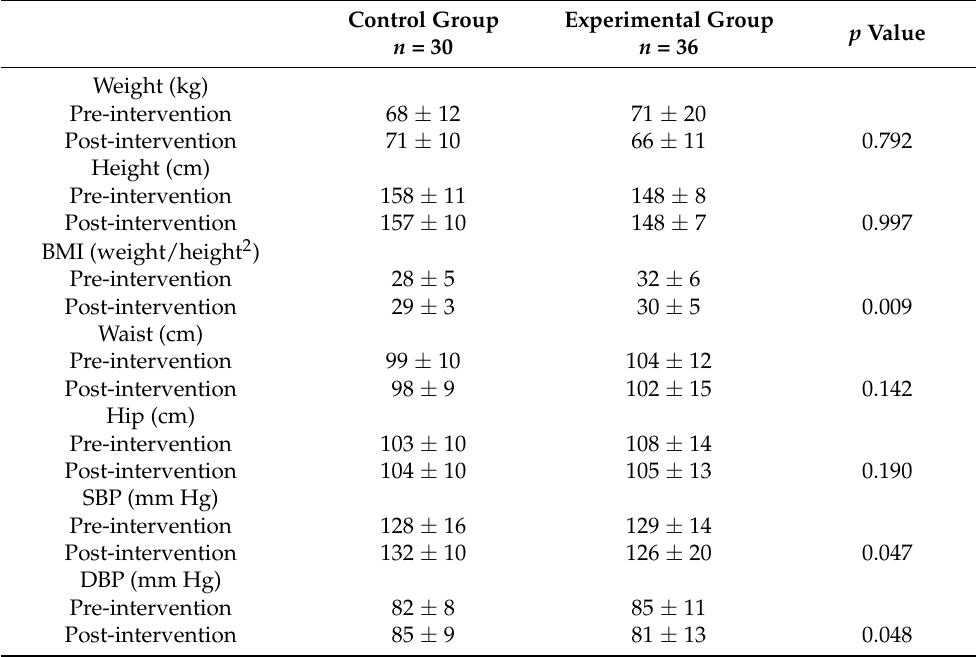
Figure 3. Percentage of the number of MS criteria pre and post-intervention. In ( A ) (control group) pre-intervention, 28/30 (94%) subjects had 3 MS criteria, 1/30 (3%) had 4 MS criteria, and 1/30 (3%) had 5 MS criteria; post-intervention, 5/30 subjects (17%) changed from 3 to 2 MS criteria, 28/30 (94%) changed to 9/30 (30%) with 3 MS criteria, 1/30 (3%) changed to 12/30 (40%) with 4 MS criteria and 1/30 (3%) changed to 4/30 (13%) with 5 MS criteria. In ( B ) (experimental group), pre-intervention 28/36 (78%) subjects had 3 MS criteria, 7/36 (19%) had 4 MS criteria, and 1/36 (3%) had 5 MS criteria; post-intervention, 2/36 subjects (6%) changed from 3 to 0 MS criteria, 12/36 (33%) changed from 3 to 1 MS criteria, 12/36 (33%) changed from 3 to 2 MS criteria, 28/36 (78%) changed to 6/36 (16%) 3 MS criteria, 7/36 (19%) changed to 2/36 (6%) with 4 MS criteria, and 1/36 (3%) changed to 2/36 (6%) with 5 MS criteria. Therefore, 25/30 (83%) of the control group, in comparison with 10/36 (28%) of the experimental group, maintained a diagnosis of MS (3 or more components) after the intervention, whose difference was statistically significant ( p < 0.001); ( A ) control group; ( B ) experimental group. Table 3. Mean numbers of MS diagnostic criteria pre- and post-intervention. Table 4. Pre- and post-intervention clinical parameters by